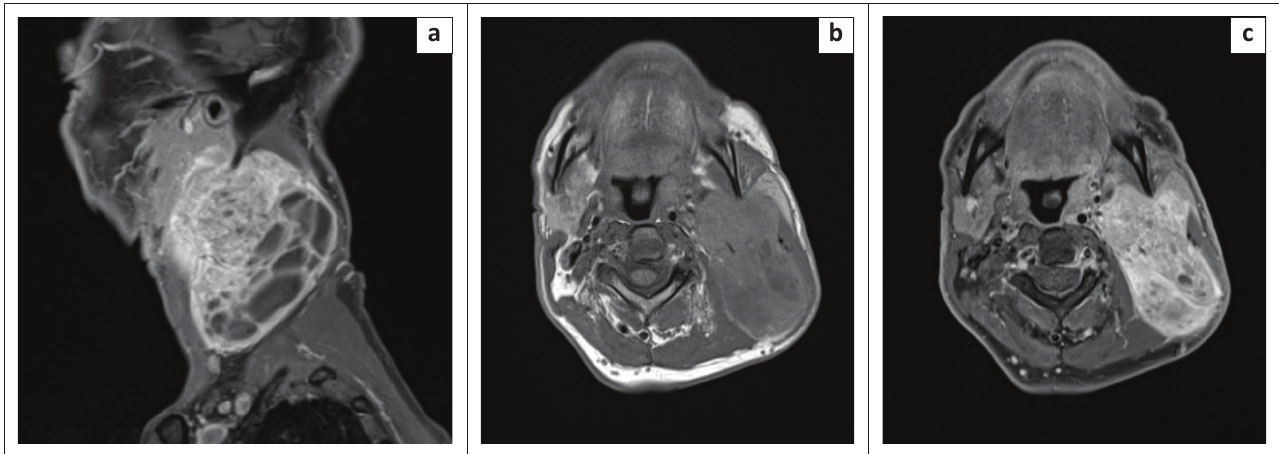
FIGURE 2: (a) Sagittal T1-weighted, post-gadolinium, fat-saturated magnetic resonance (MR) image shows the mixed solid–cystic nature of the cervical nodal-mass with enhancement of the cranial solid portion. Superficial parotid gland infiltration was suspected based on MR imaging findings. Axial T1-weighted MR images with (b) gadolinium and (c) fat suppression demonstrating heterogenous enhancement of the solid cranial portion of the cervical nodal-mass conglomerate. The left carotid arteries and internal jugular vein were not